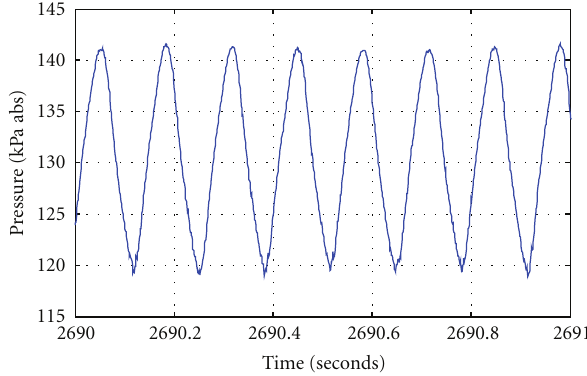
Figure 16: Pressure fluctuations in the exhaust (discharge plenum) after audible change at 16,000 rpm.